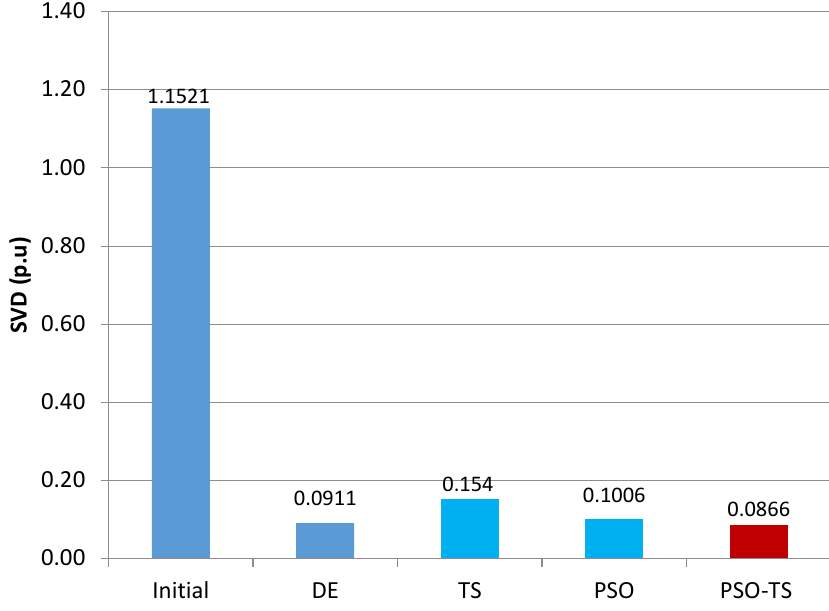
Figure 11. Comparative graph of the voltage deviation objective (SVD) (Case 2).